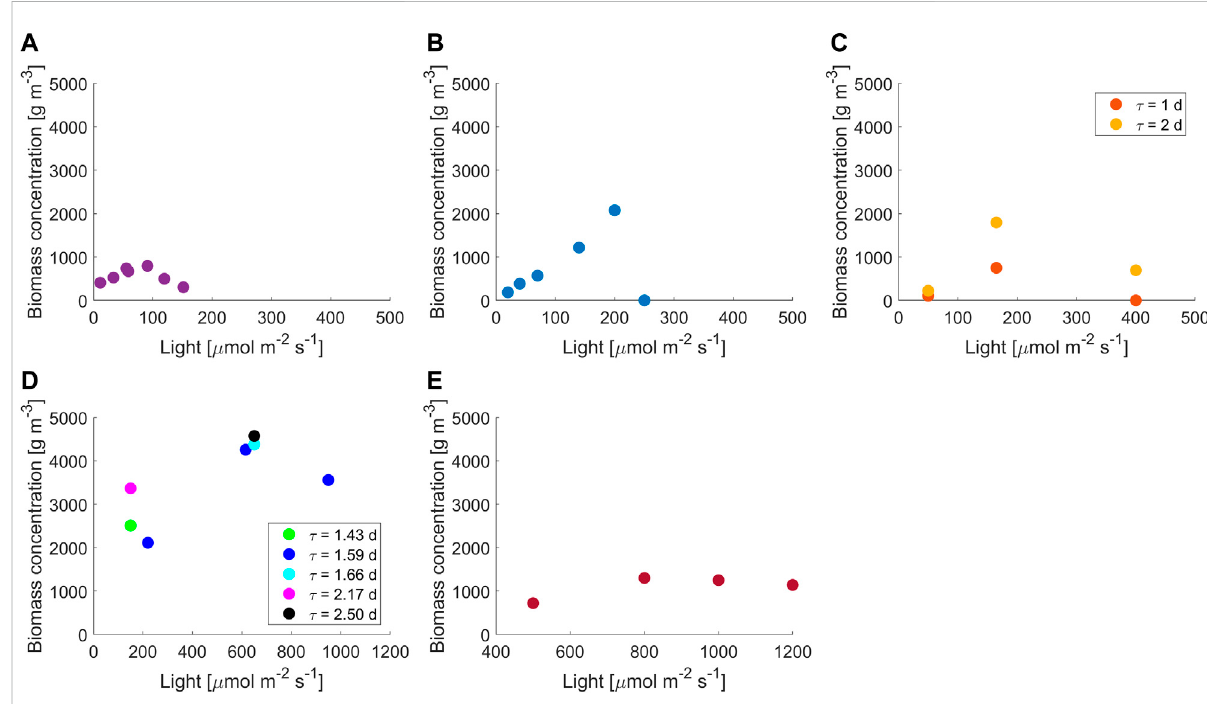
FIGURE 1 Experimental results at different light intensities and residence times for reactor thicknesses of (A) 2 mm, 1.5 days; (B) 5 mm, 1 day; (C) 8 mm, 1 – 2 days; (D) 15 mm, 1.43 – 2.5 days (E) 35 mm, 1.05 days. Data at 15 mm are from Barbera et al. (2017) and Sforza et al. (2015b); data at 35 mm are from Borella et al. (2021).